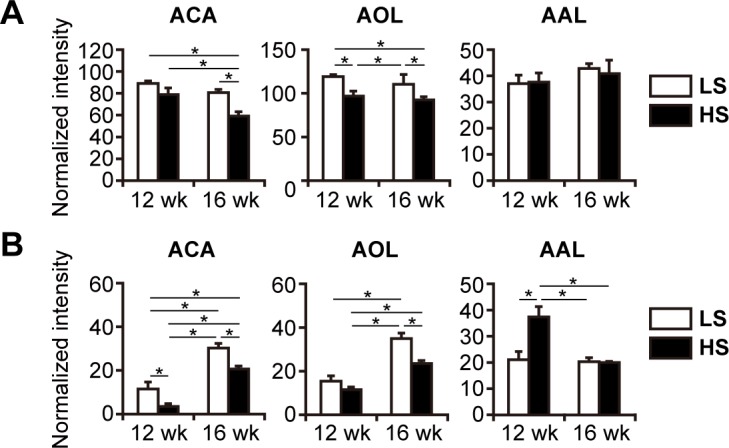
Lectin microarray analysis of LV extracts and plasma.Reactivity of fucose-binding lectins AOL and AAL, and mucin-type O-glycan-binding lectin ACA was analyzed in LV extracts (A) and plasma depleted of high-abundance proteins (B) of DS rats (n = 3). Entire lectin microarray datasets are shown in the S3 and S4 Tables. Data are presented as normalized intensity. *, p < 0.05 (Tukey-HSD).